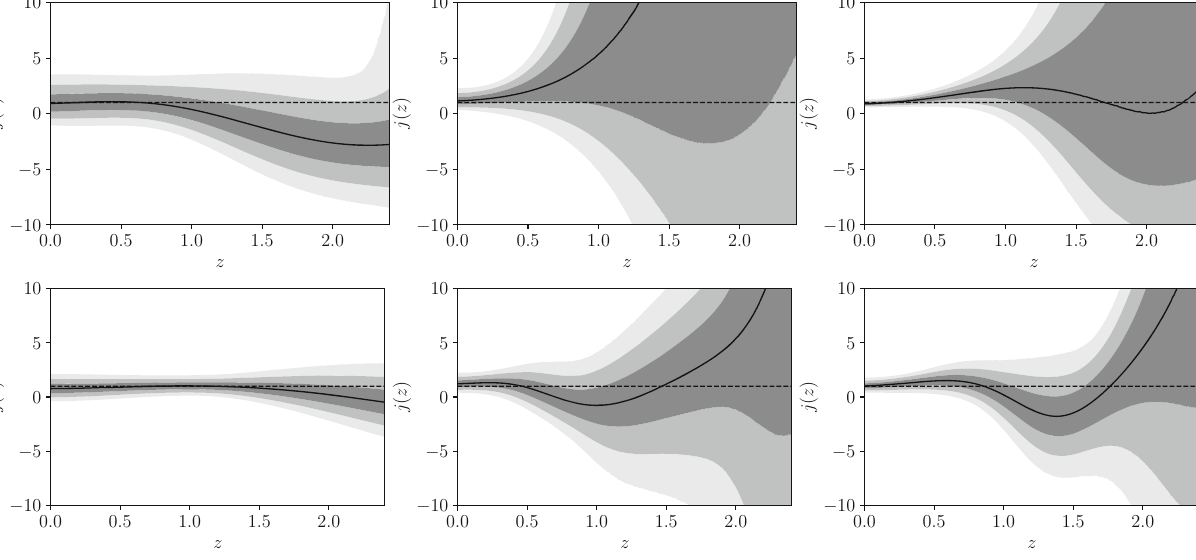
Fig. 10 Plots for j ( z ) reconstructed from CC data (top left), Pantheon data (top middle), CC + Pantheon data (top right), CC + BAO data (bottom left), Pantheon + BAO + CMB data (bottom middle), and CC + Pantheon + BAO + CMB data (bottom right). The solid black line is the “best fit”. The black dashed line represents the (cid:2) CDM model with (cid:12) m 0 = 0 . 3 where j = 1 Table 5 Table showing the reconstructed value along with the 1 σ uncertainty of q 0 and j 0 corresponding to the different datasets used